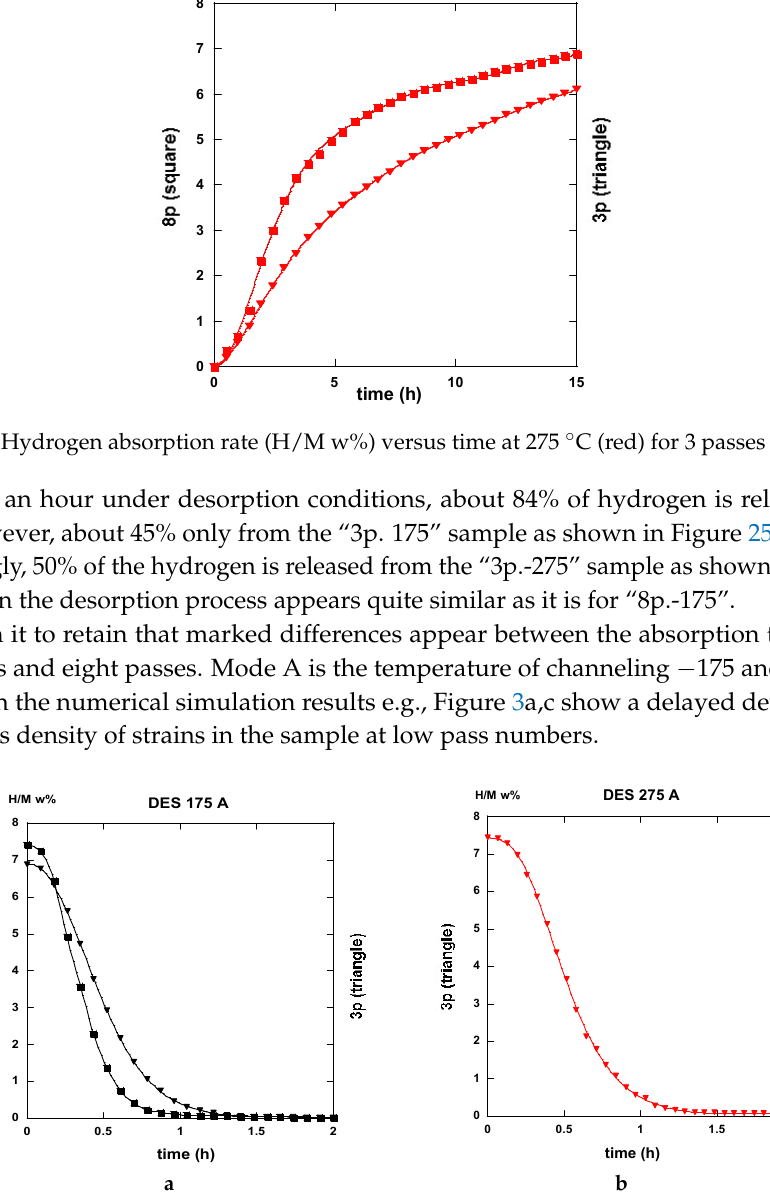
Figure 25. Hydrogen desorption rate (H/M w%) versus time of samples: a —for 3 passes (triangles) and for 8 passes (squares) as treated at 175 °C (black).; b —for 8 passes as treated at 275 °C (red).